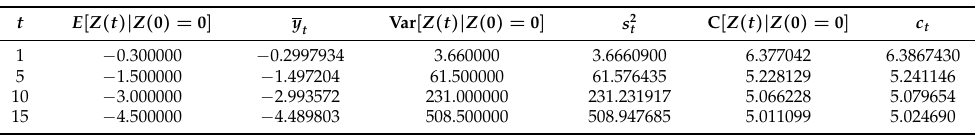
Table 2. For the same choices of the parameters of Figure 4, the conditional mean, variance, and coefficient of variation of Z ( t ) are compared with the estimated values y means of Algorithm